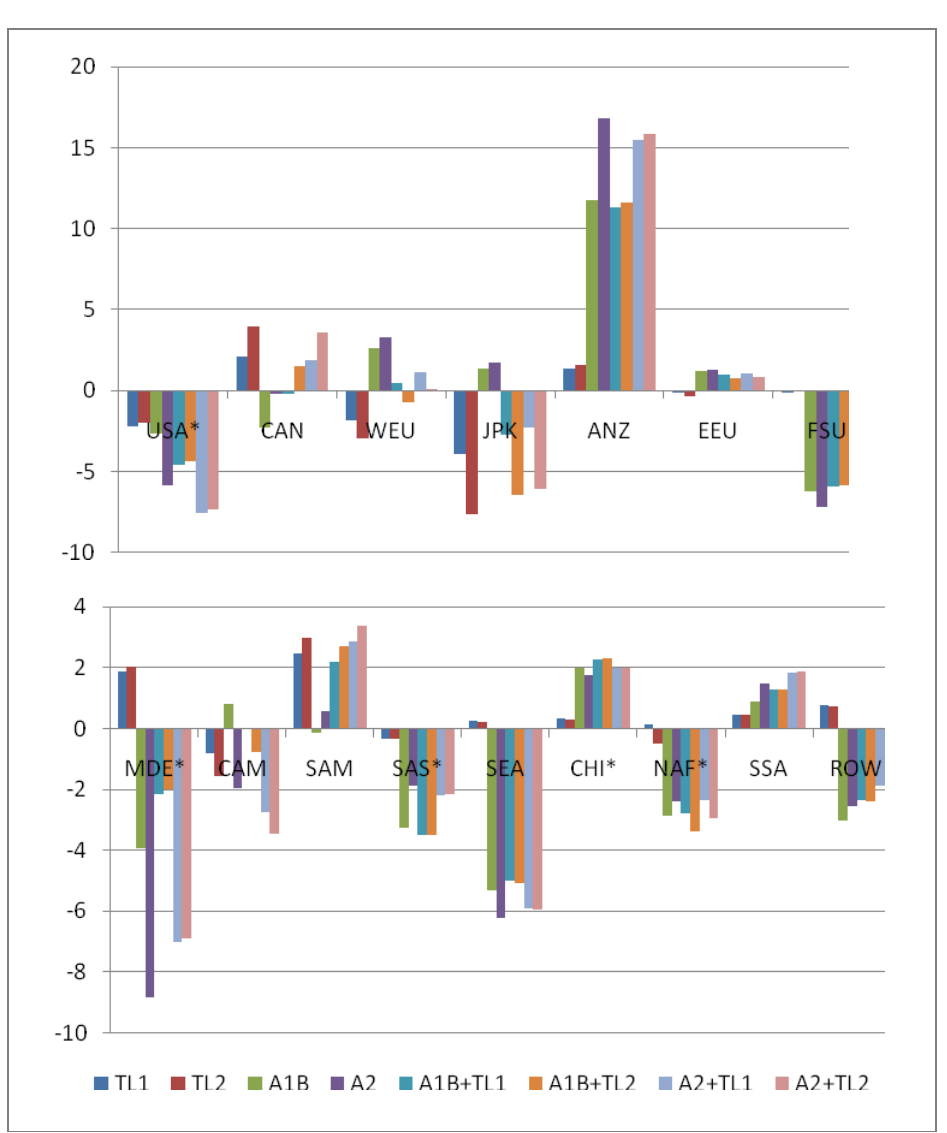
Figure 4. Change in agricultural water use in 2020 relative to baseline (in